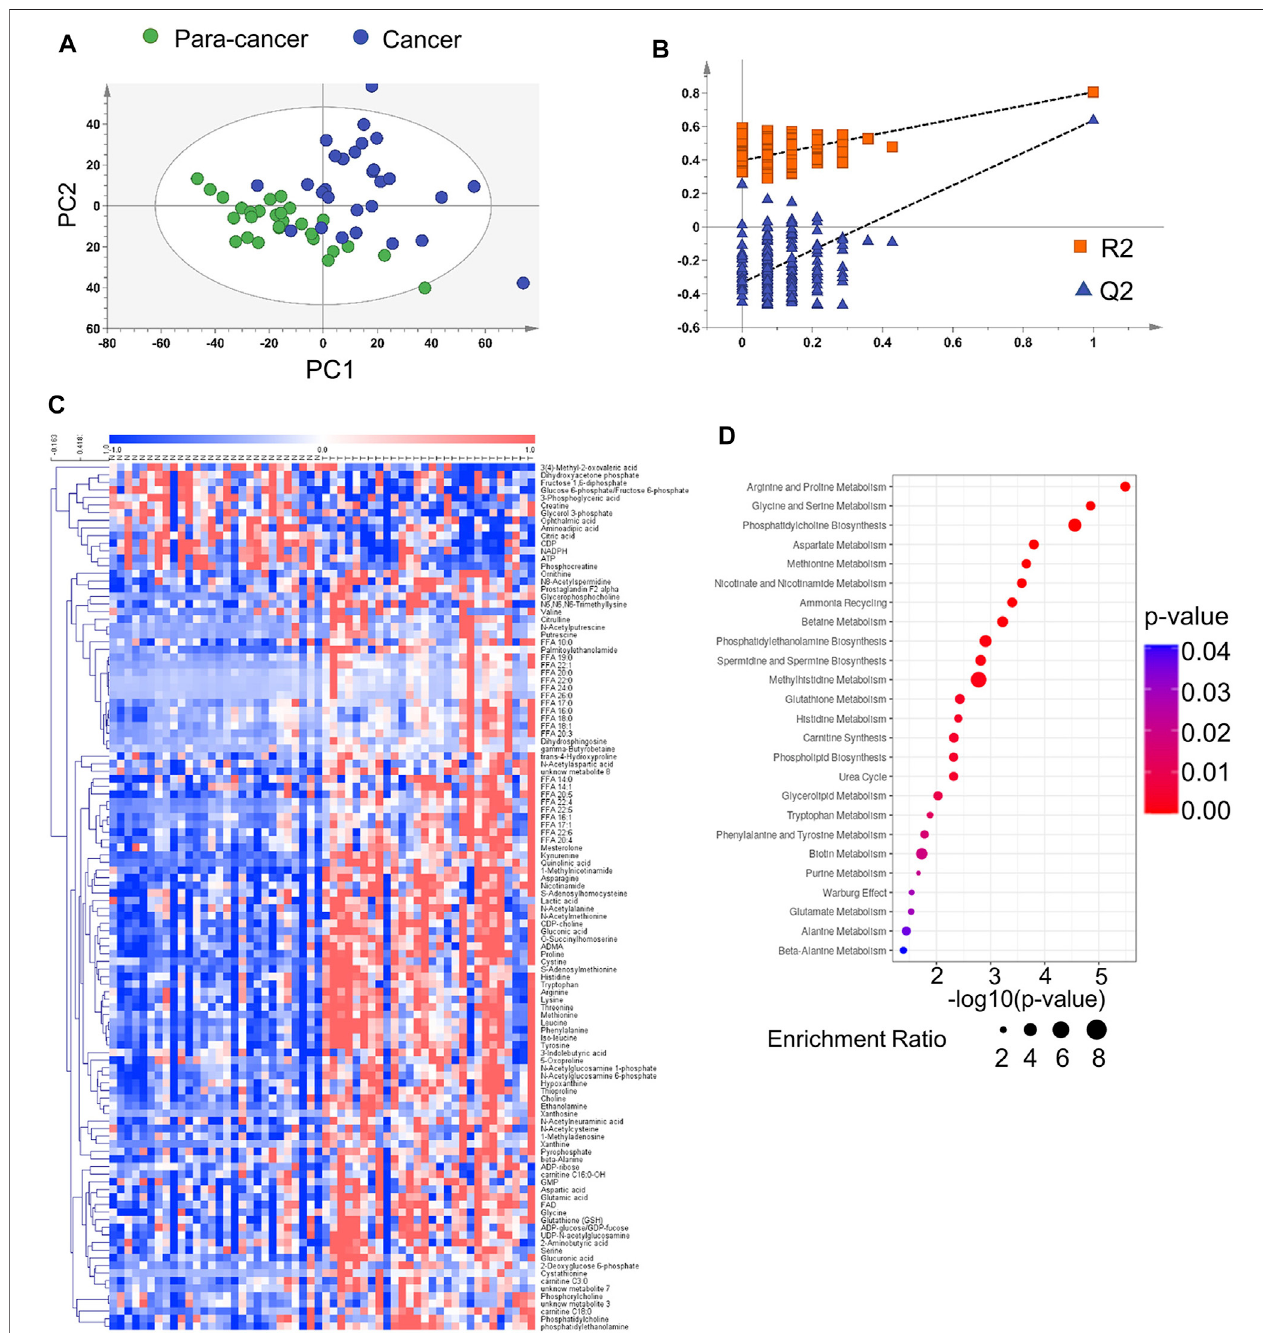
FIGURE 1 | Metabolomic analysis of ESCC and para-cancer tissues. (A) . PLS-DA score plot of ESCC and para-cancer tissues. (B) . PLS-DA validation plot and para-cancer tissues. The Q2 and R2 indicated predictive ability and explanation ability of the model, respectively. The intercept of Q2 and R2 were 0.345 and 0.395, respectively. (C) .Heatmapanalysisofalldifferentialmetabolitesbetweenandpara-cancertissues. (D) .MetaboAnalystanalysisofmetabolicpathwaysby112differential metabolites ( p < 0.05).